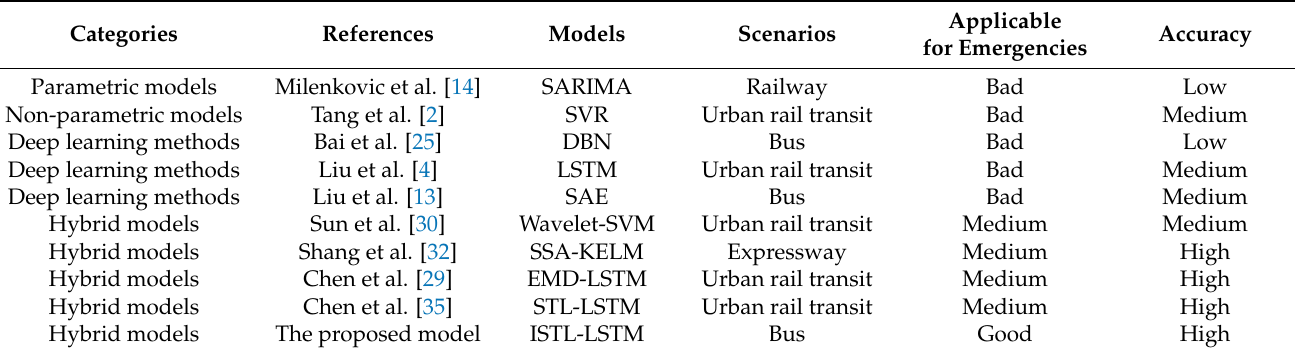
Table 1. Comparison of some existing methods concerning passenger flow